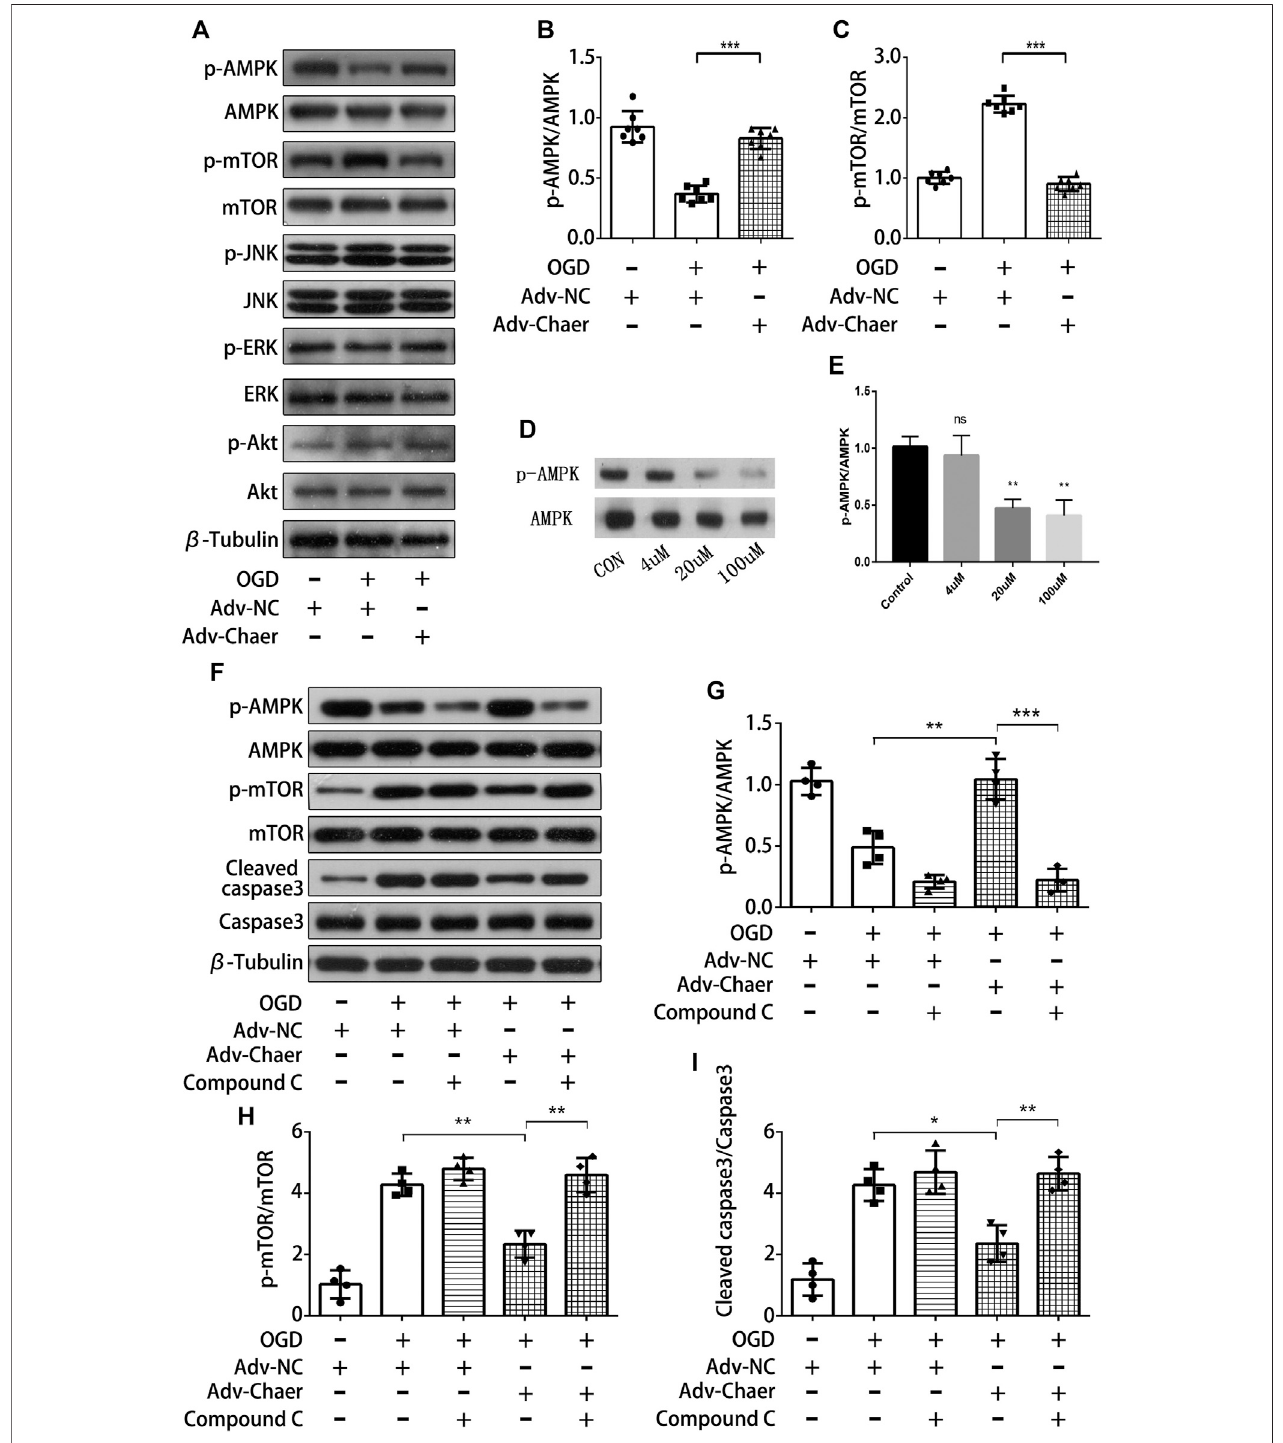
FIGURE5 | LncRNA Chaer attenuates cardiomyocytes apoptosis through its abilityto promote activation of AMPK (A) LncRNA Chaer-stimulated phosphorylation signaling in cardiomyocytes. Changes in the phosphorylation levels of AMPK (p-AMPK), mTOR (p-mTOR), JNK(p-JNK), ERK(p-ERK) and Akt (p-Akt) under OGD treatments with overexpression of lncRNA Chaer were determined by Western blot analysis. (B, C) Quantitative data of AMPK (p-AMPK) and mTOR (p-mTOR) under OGDtreatmentswithoverexpressionoflncRNAChaer. ***p < 0.001,n (cid:1) 7. (D,E) RepresentativeWesternblottingresultsandquantitativedataofAMPK( p -AMPK) after Compound C (0,4,20,100 μ M) treatment. **p < 0.01, n (cid:1) 3 . (F – I) Representative Western blotting and quanti fi cation of AMPK (p-AMPK), mTOR (p-mTOR) and Cleaved caspase3 expression in cardiomyocytes with Compound C and OGD treatments. *p < 0.05, **p < 0.01, ***p < 0.001, n (cid:1) 4 .